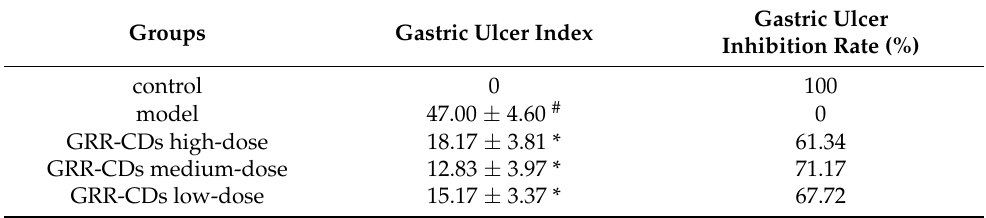
Table 1. Comparison of anti-gastric ulcer activity of different doses of